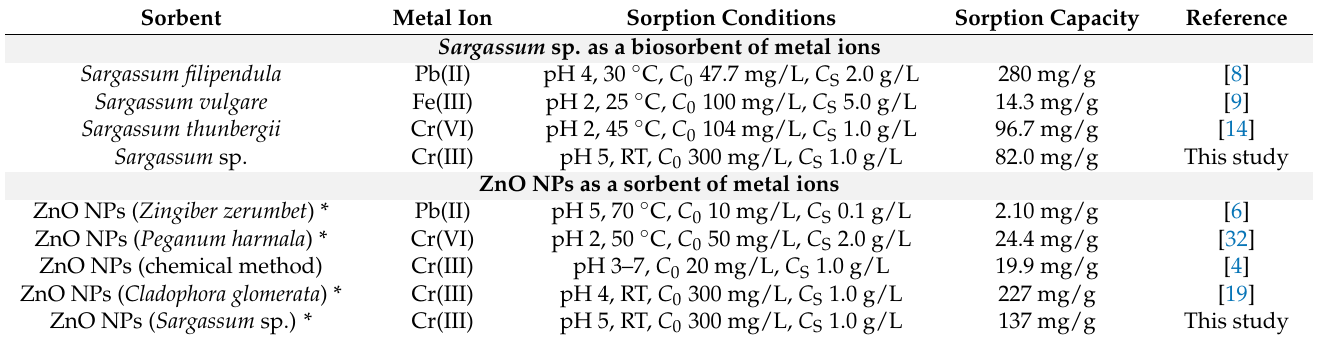
Table 5. Comparison of the values of sorption capacities determined on the basis of kinetic models depending on the sorption conditions, metal ion, and sorbent